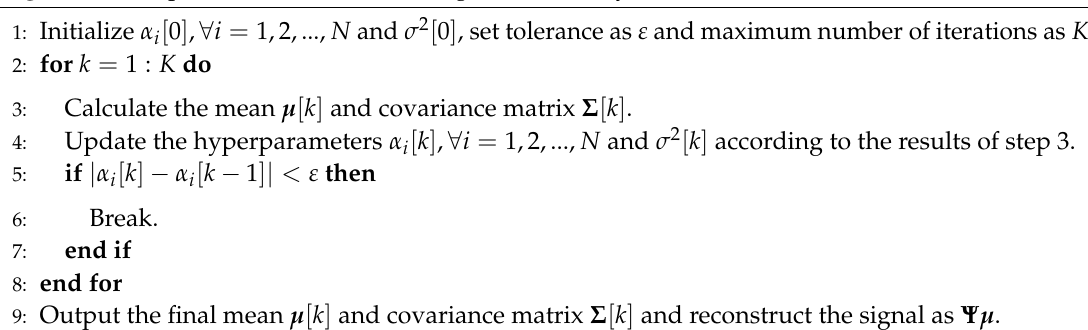
Algorithm 1 Expectation maximization algorithm for Bayesian estimation